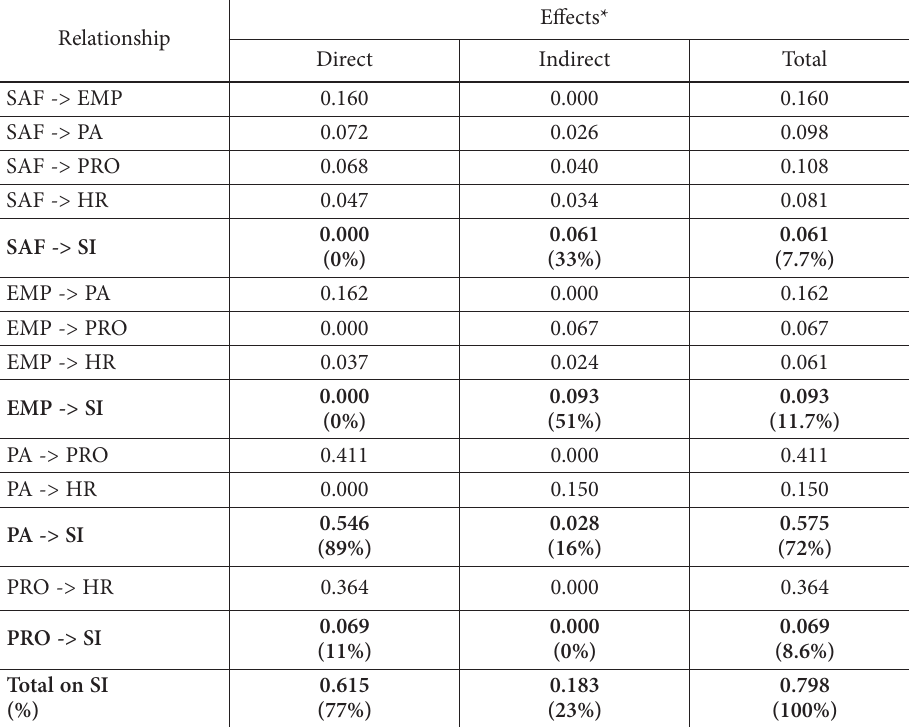
Table 3. Total, direct and indirect effects and the ratio of the explained variance in Social